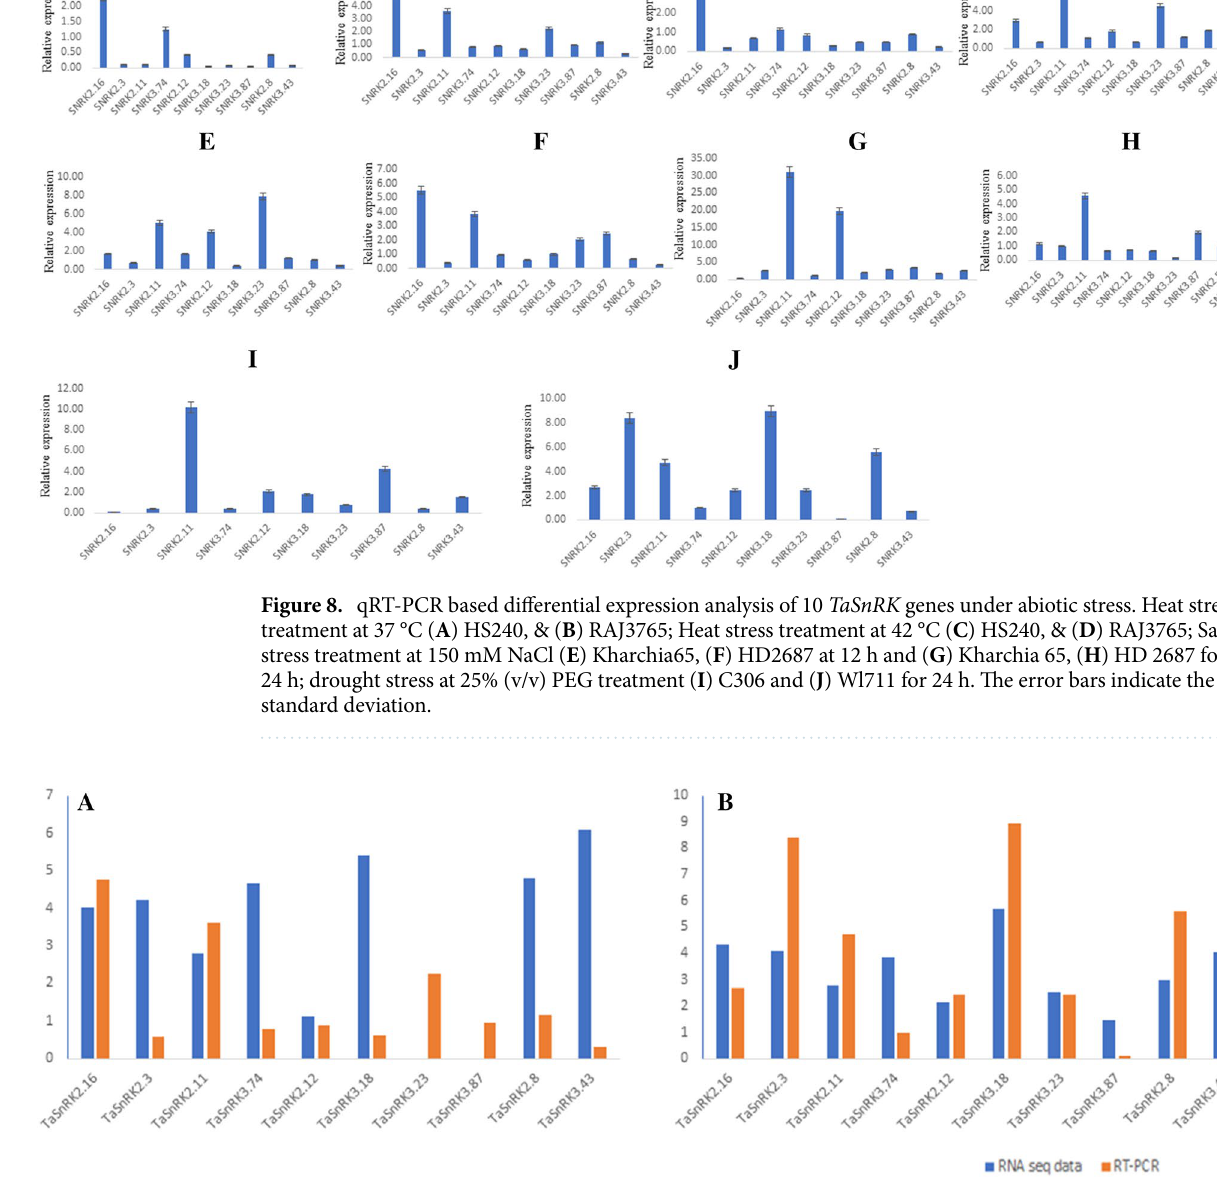
Figure 9. Comparison between magnitude of gene expression of RNA-seq and qRT-PCR data of heat stress ( A ) and drought stress ( B